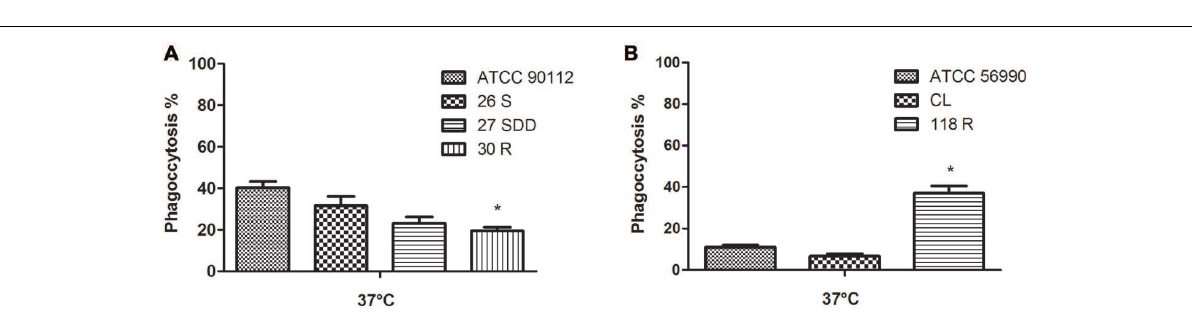
FIGURE 8 | Phagocytosis index after infection in G. mellonella . (A) ATCC 90112 and isolates 26S, 27SDD, and 30R of C. neoformans ; (B) ATCC 56990 and isolates 118R and CL of C. gattii. ∗ p <